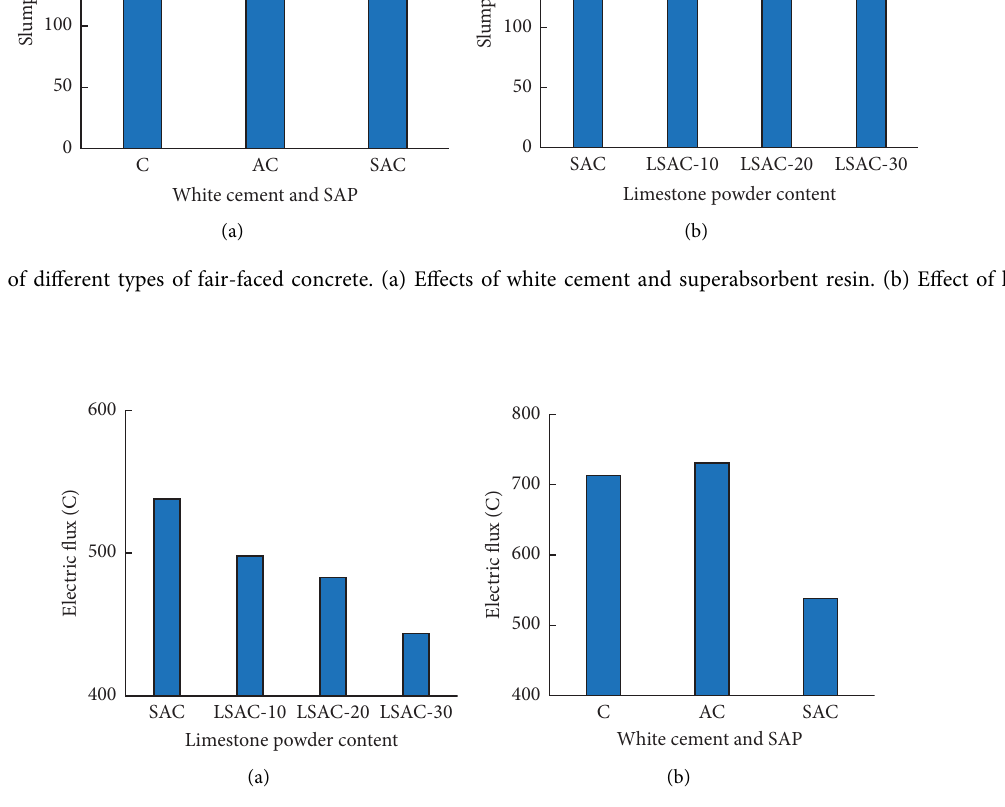
Figure 3: Electric fux of diferent types of fair-faced concrete. (a) Efect of limestone powder content. (b) Efects of white cement and SAP.